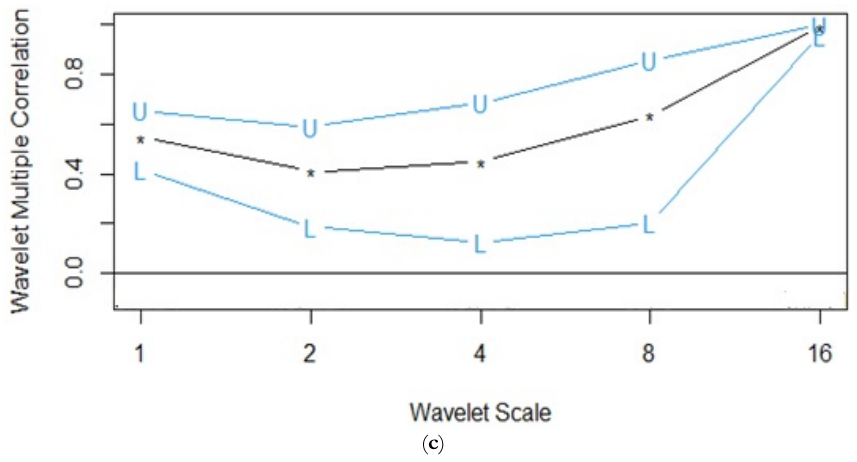
Figure 4. Wavelet multiple correlation of macroeconomic variables (February 1997 to May 2019).